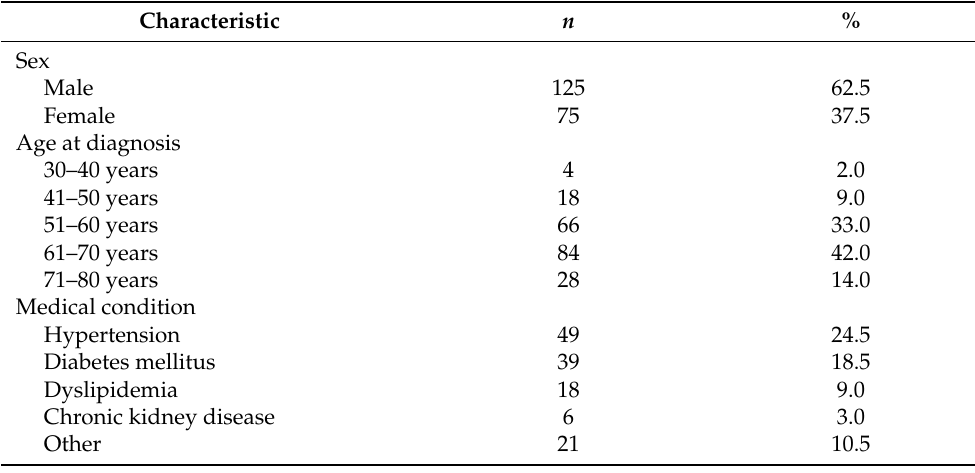
Table 1. General characteristics of participants ( n =